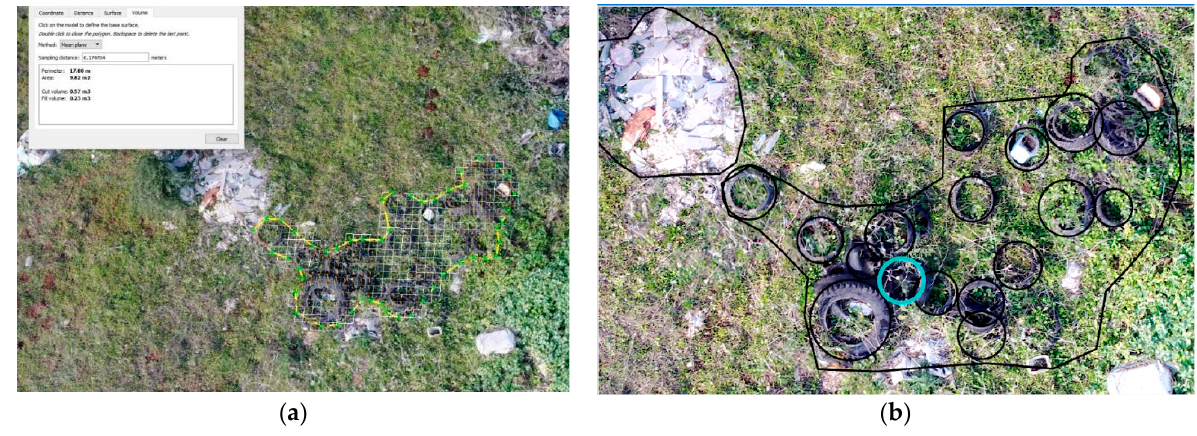
Figure 2. Orthophotos of illegal waste dumping sites. Site #1—tire waste; area 9.82 m 2 , volume 0.57 m 3 . ( a , b are the same site in different resolutions; b represent the manual identification).